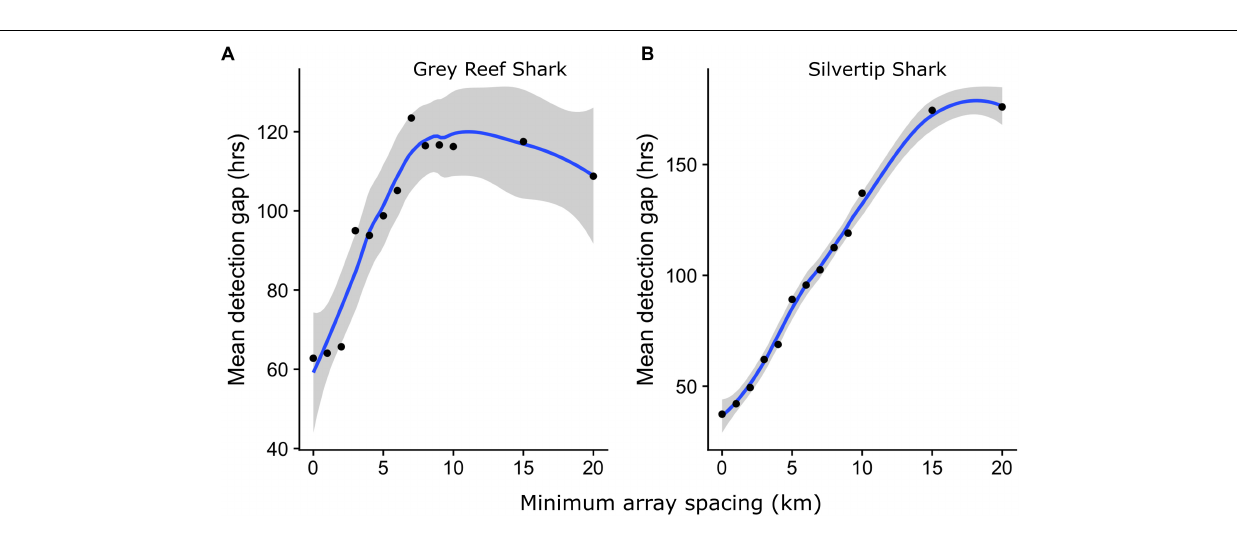
FIGURE 7 | Mean (blue line, shaded area 95% confidence interval) duration of gaps in detection for (A) Grey Reef and (B) Silvertip Sharks, by minimum receiver distance in